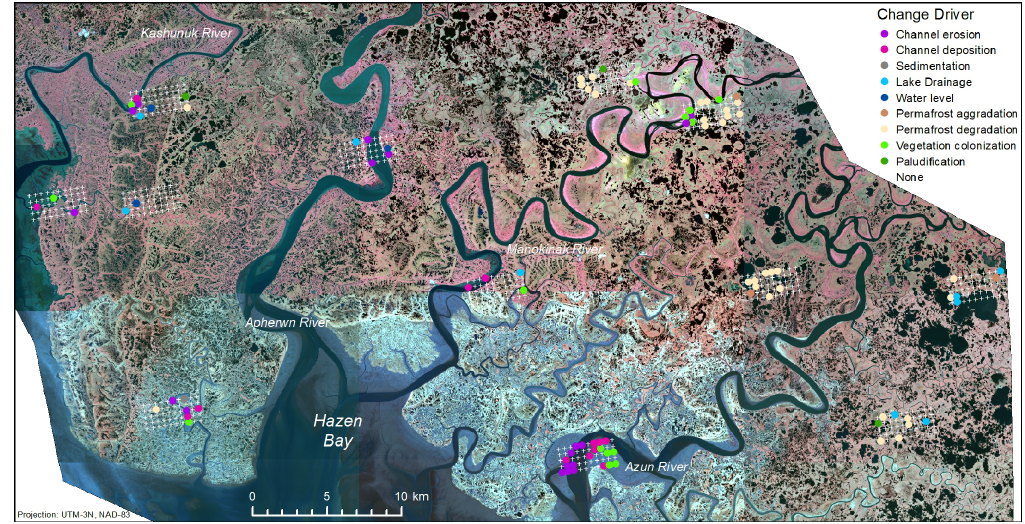
Figure 7. Distribution of points where landscape change was detected along the central coast of the Yukon-Kuskokwim